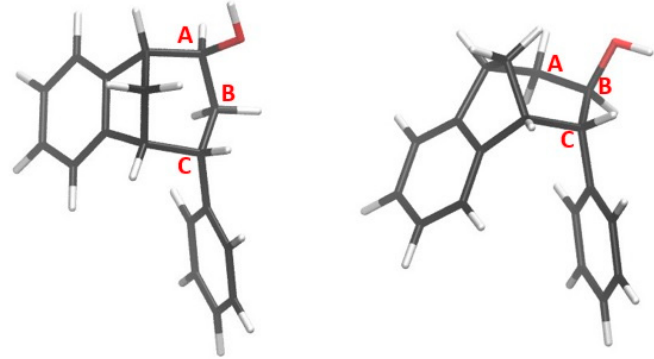
Figure 8. Alcohols formed from products of reactions (1) and (2).